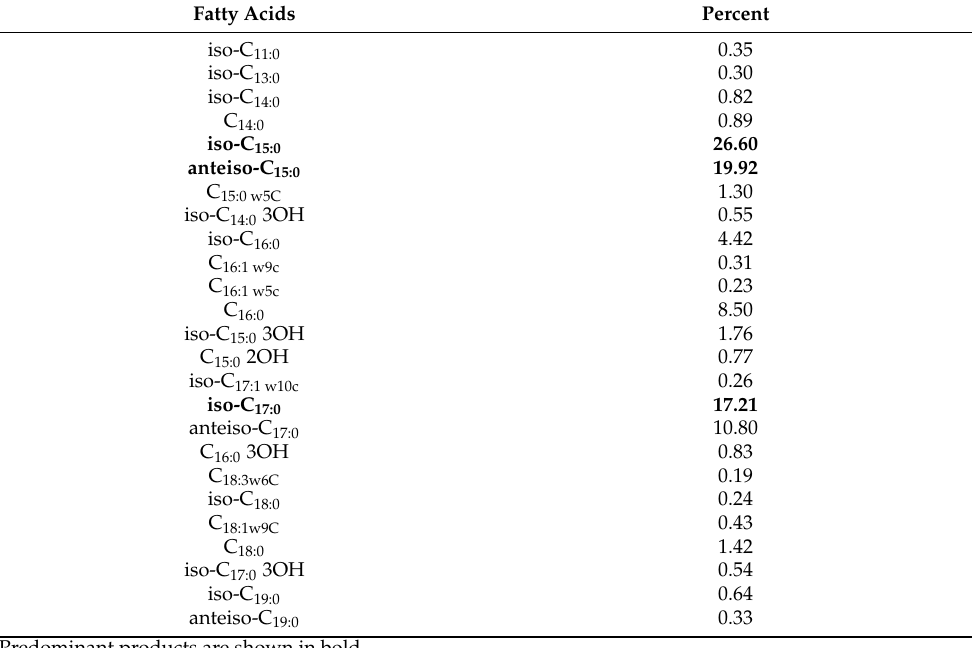
Table 2. Cellular fatty acid composition (%) of strain kh20 T .